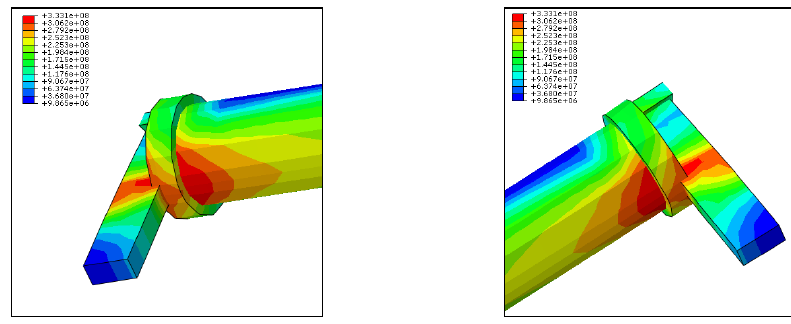
Figure 6. Tensile failure mode of the socket on the horizontal bar.